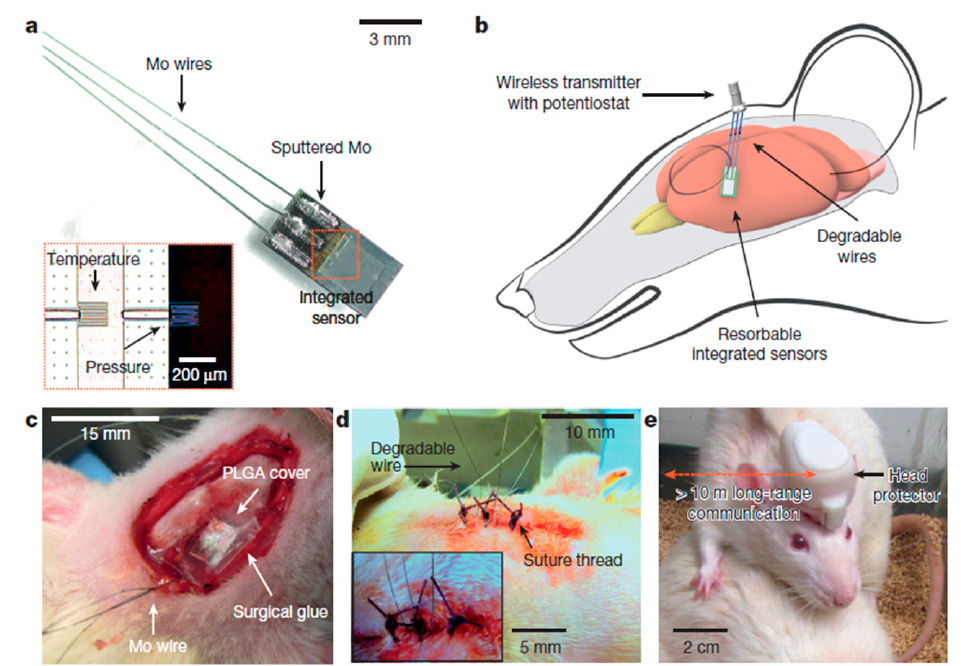
Figure 4. Schematic diagram to represent the interfacing of Bioresorbable sensors with the communication modules for the wireless data transfer. The image also shows the connection of the bioresorbable pressure and temperature sensors integrated with the dissolvable metal interconnect [92]. The image has been reproduced with permission from [92].